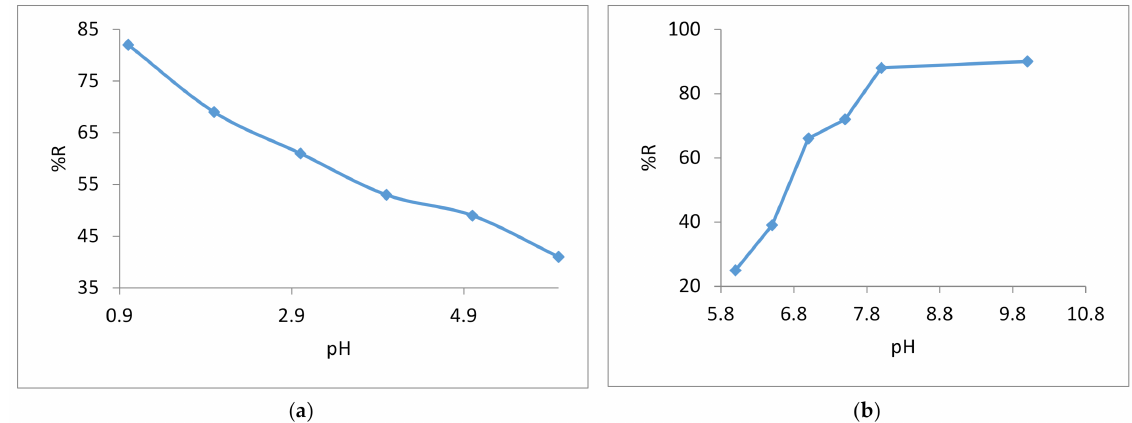
Figure 7. Effect of pH on % removal of: ( a ) acid red 4 ( b ) methylene blue.